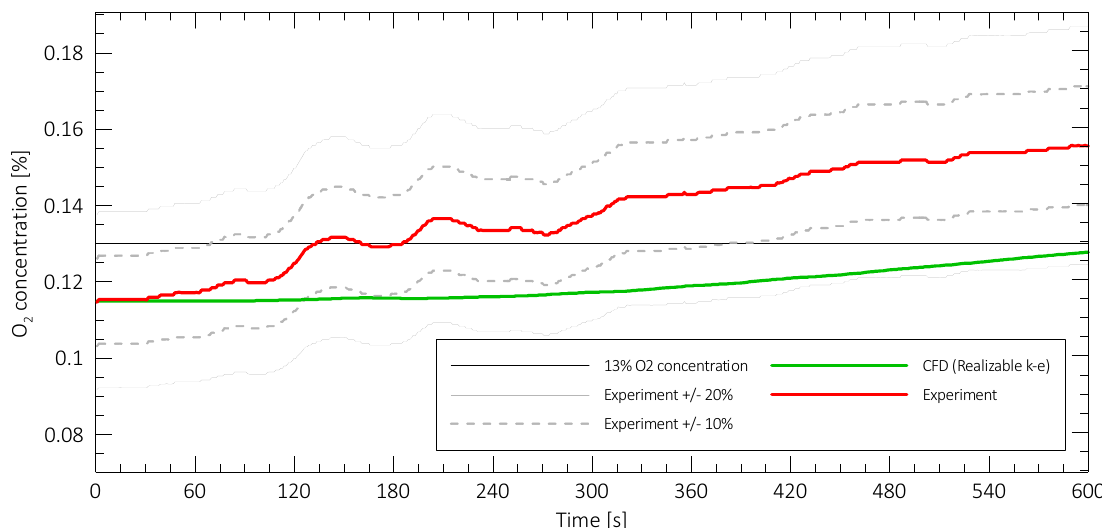
Figure 16. Changes in oxygen concentration (v/v) on the probe No. 5, indicating the end of the retention time during experimental tests and CFD simulations, fire-extinguishing gas Ar 6.9% v/v and N 2 93.1% v/v.